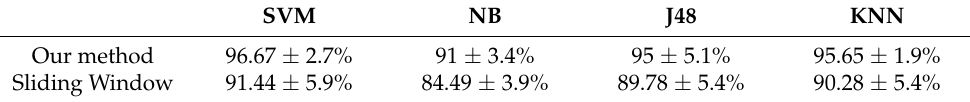
Table 4. Recognition accuracy of both segmentation methods using different classification algorithms.